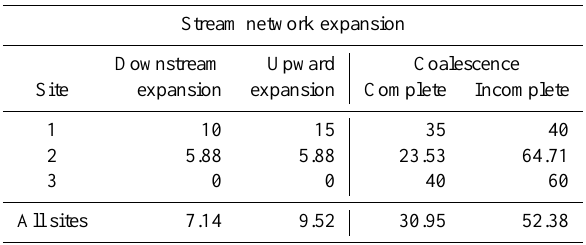
Table 4. Occurrence of each model of expansion as a percent of all